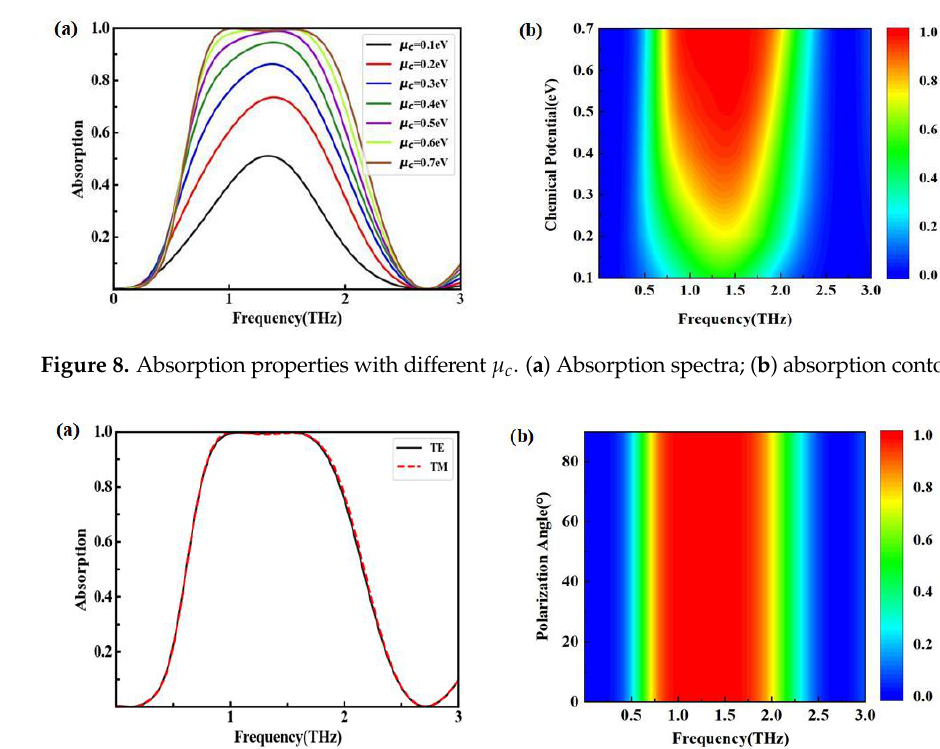
Figure 8. Absorption properties with different 𝜇 view.